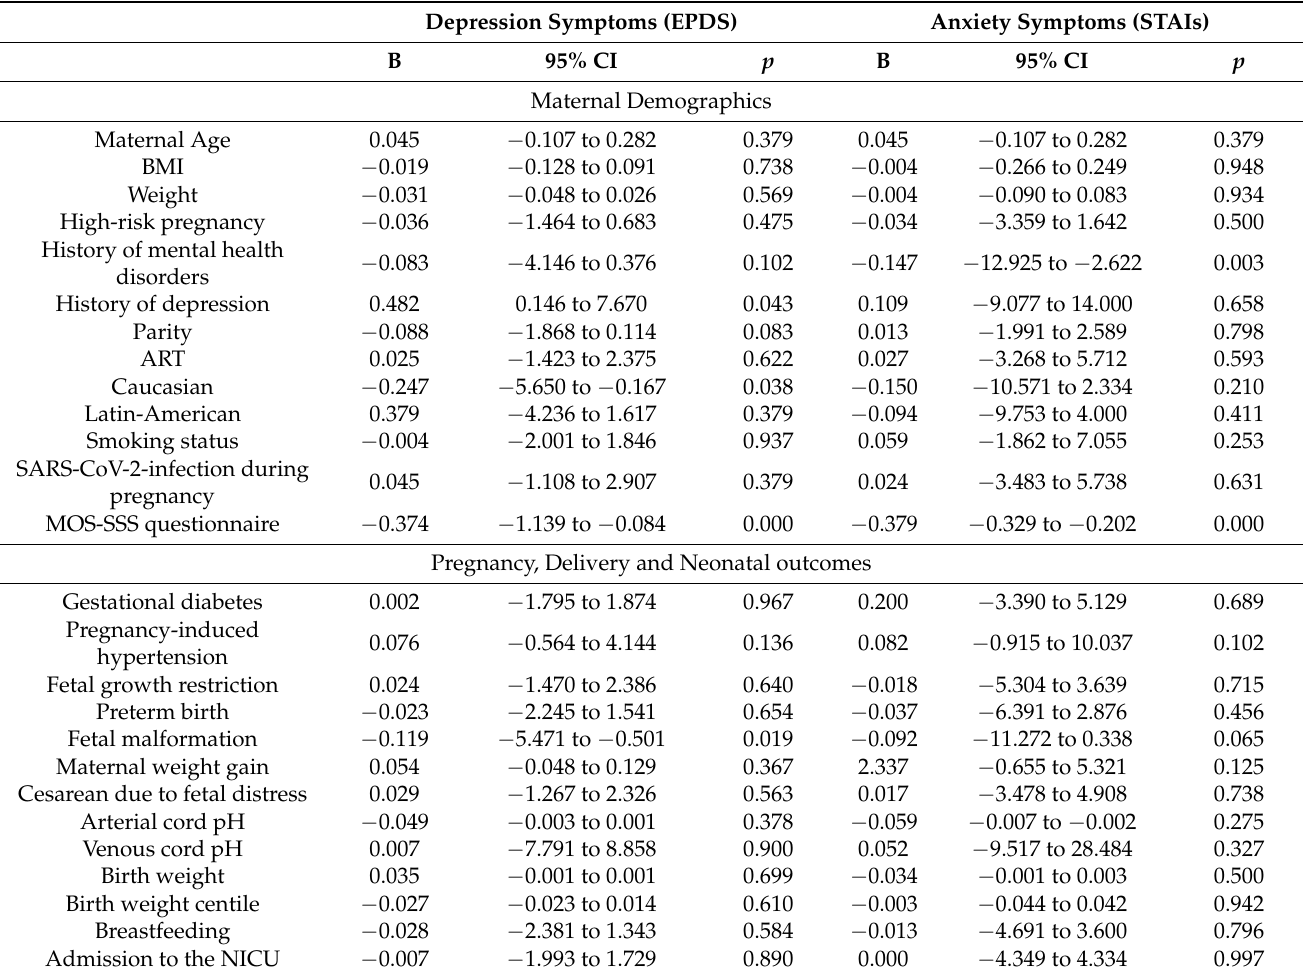
Table 3. Univariate linear regression logistic analysis for depression (EPDS) and anxiety (STAIs) symptoms, and demographic, pregnancy, delivery and neonatal variables ( n =